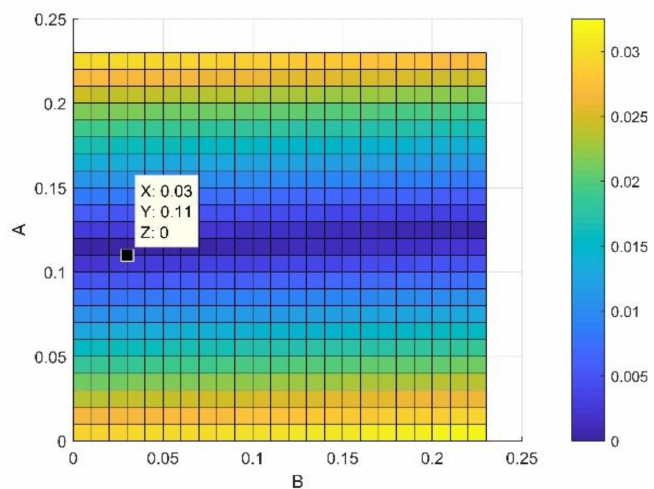
Figure 10. Optimization of A and B factors.